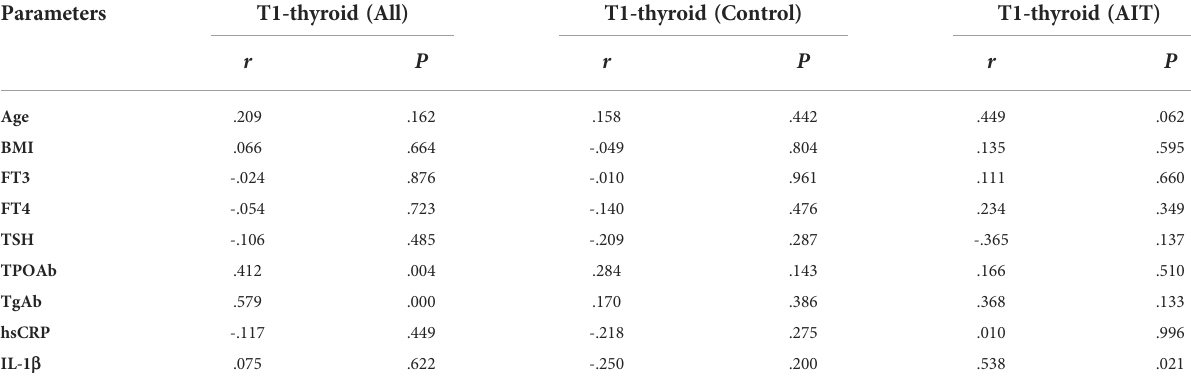
TABLE 2 Correlation between thyroid T1-mapping values and clinical parameters.